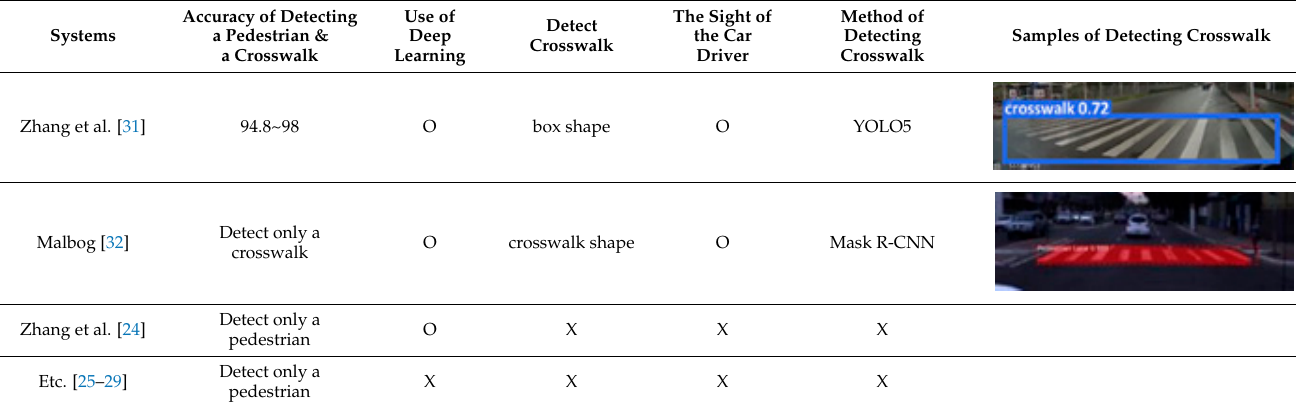
Figure 1. Overall process: CNN-based crosswalk-pedestrian situation recognition system using Mask-R-CNN.